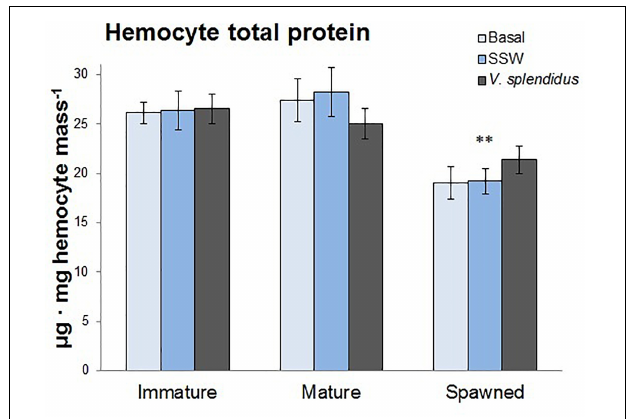
FIGURE 6 | Effects of in vivo challenge with V. splendidus on hemocyte total protein content in immature, mature, and spawned A. purpuratus ( n = 4–8 per condition and treatment; ∗∗ P < 0.001).